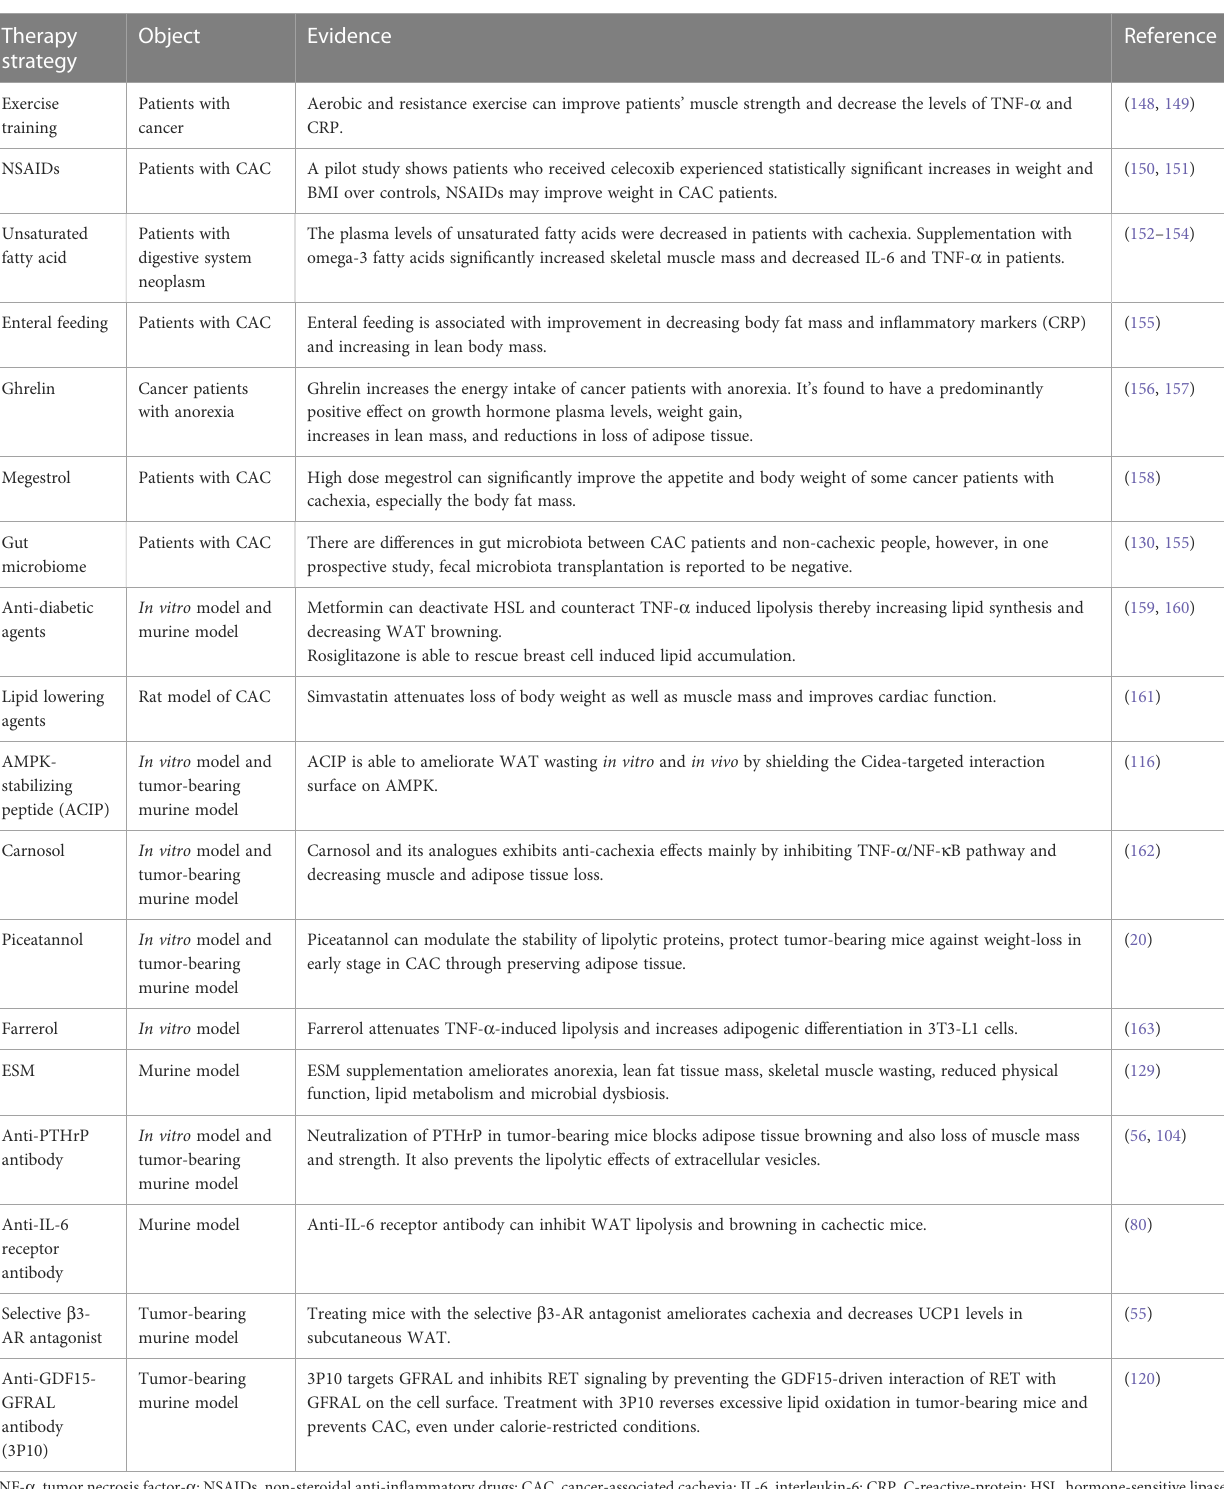
TABLE 1 Potential therapeutic strategies for lipopenia in